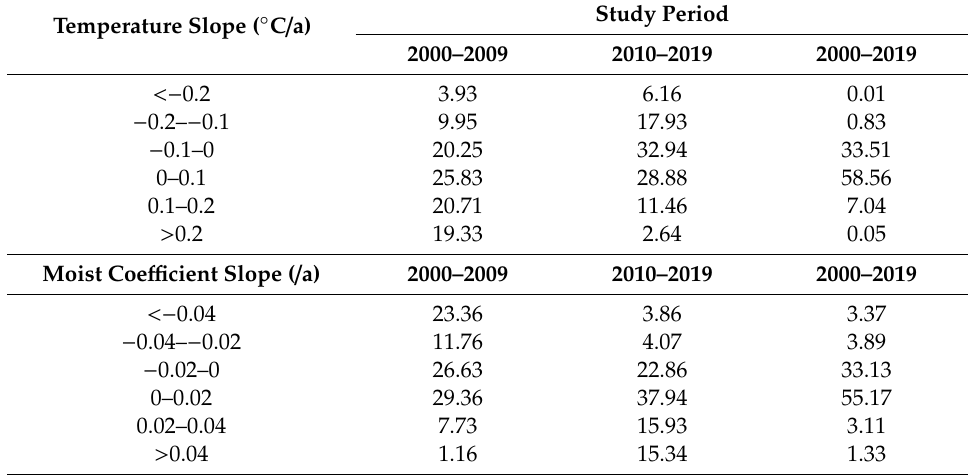
Table 3. The areal proportion of di ff erent climate change rates in di ff erent study periods on the QTP